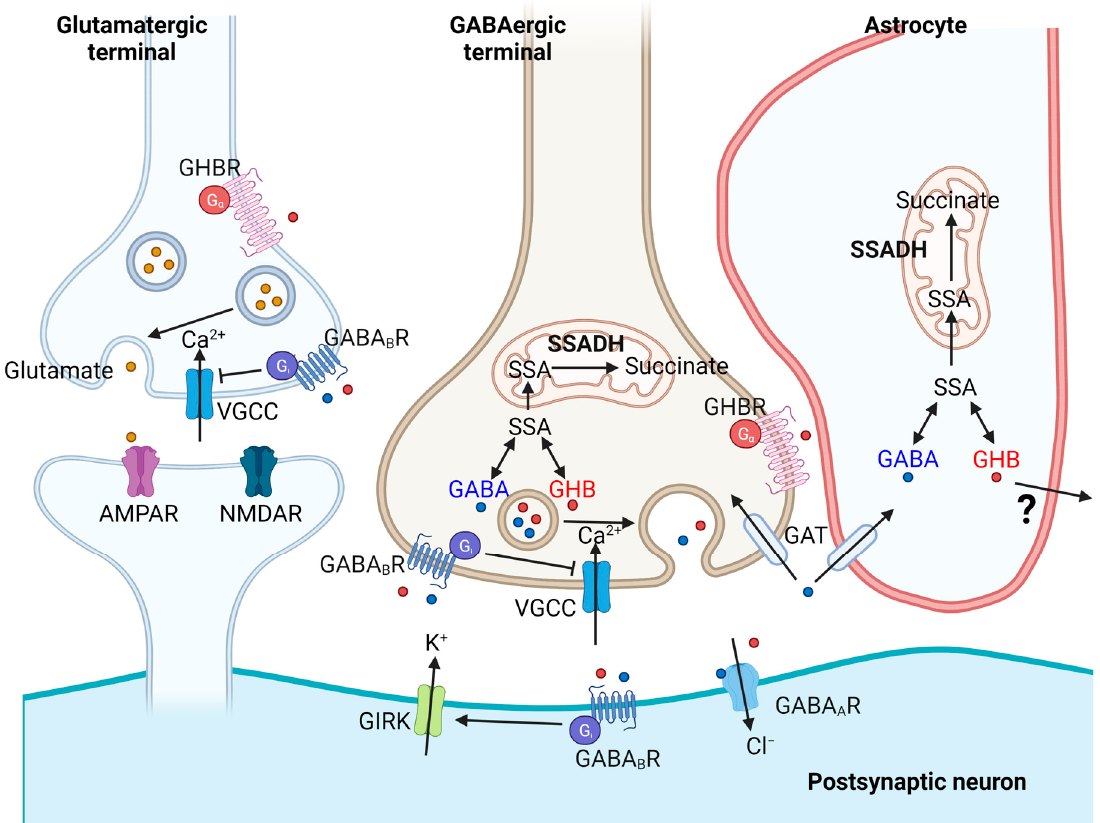
Figure 3. Schematic diagram showing key synaptic mechanisms relevant for SSADHD. SSADH is a mitochondrial enzyme essential for the conversion of SSA (succinic semialdehyde) to succinate downstream of γ -aminobutyric acid (GABA) catabolism. In SSADHD, presynaptic release of GABA and metabolic by-product γ -hydroxybutyrate (GHB) from GABAergic terminals activate type-A and type-B GABA receptors (GABA A R, GABA B R) and GHB receptors (GHBR). GABA A R is an ionotropic chloride channel, which mediates postsynaptic hyperpolarization. GABA B R is a metabotropic G- protein coupled receptor, which mediates presynaptic blockade of voltage-gated calcium channels (VGCC) for synaptic vesicle release, and postsynaptic activation of G-protein-coupled inwardly rectifying potassium (GIRK) channels. Recycling of GABA into GABAergic terminals and astrocytes is mediated through the specific GABA transporter (GAT). G-protein coupled GHBRs are involved in both glutamatergic and GABAergic